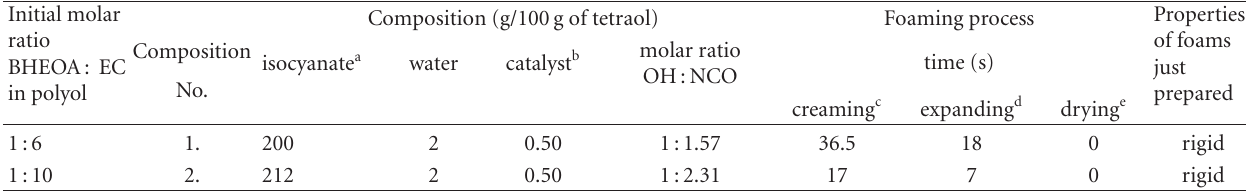
Table 4: Parameters of foaming process.